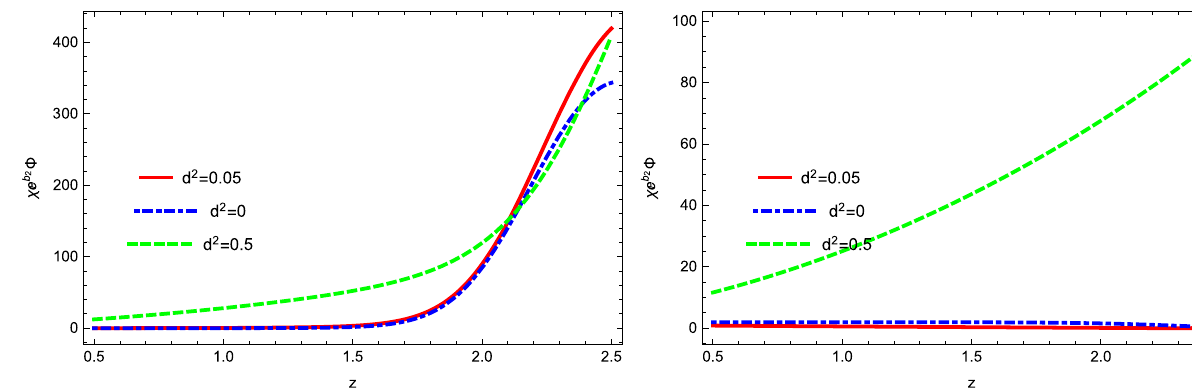
Fig. 14 Plot of χ e b 2 φ verses z for u = 1 and u = 2 . 002 for dilaton scalar field model